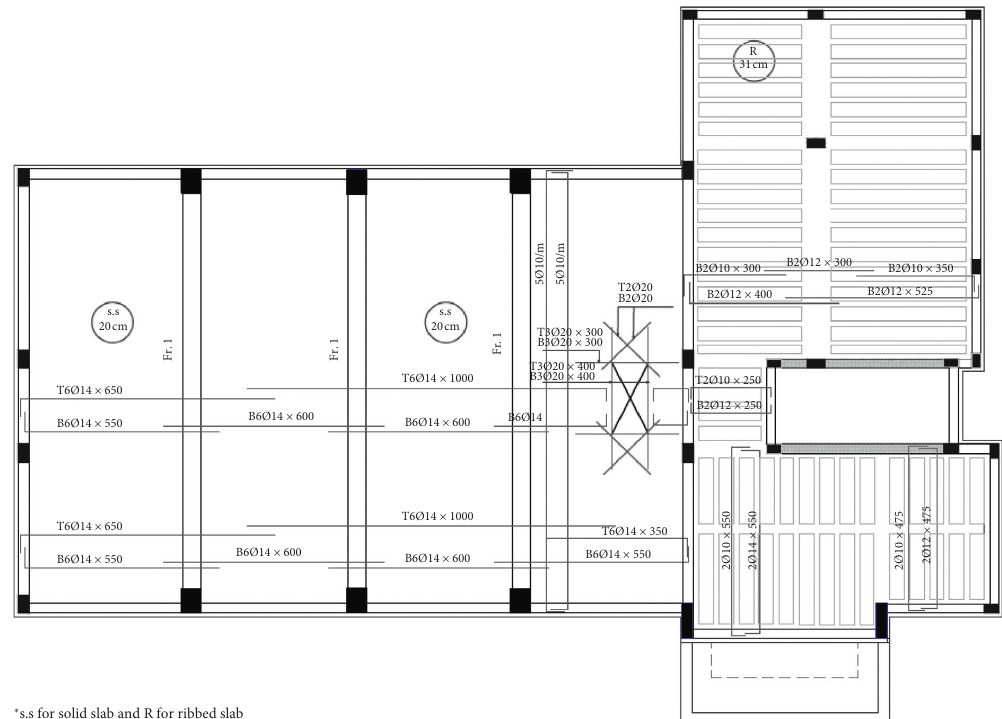
Figure 23: Conventional